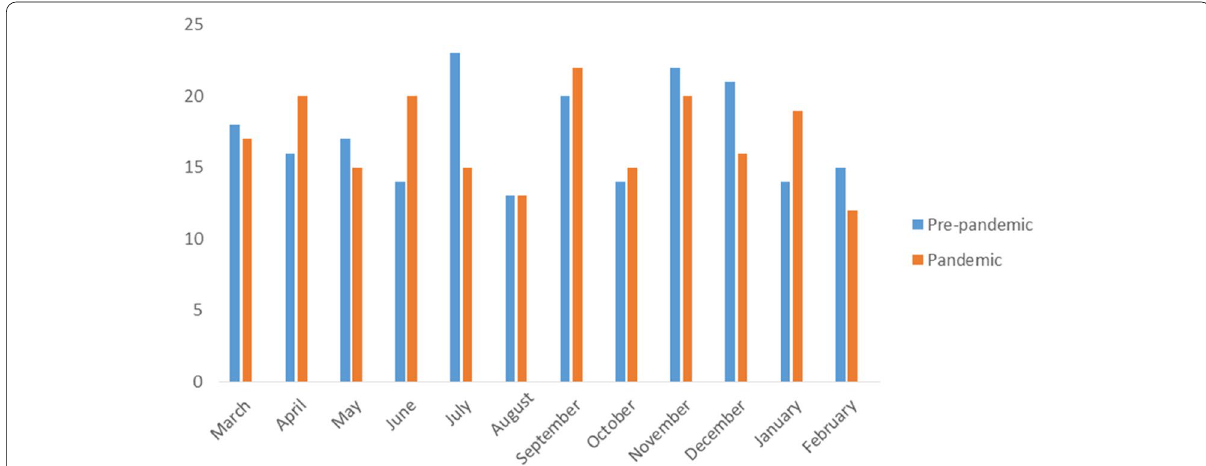
Fig. 1 The number of appendicitis in the pre-pandemic and pandemic